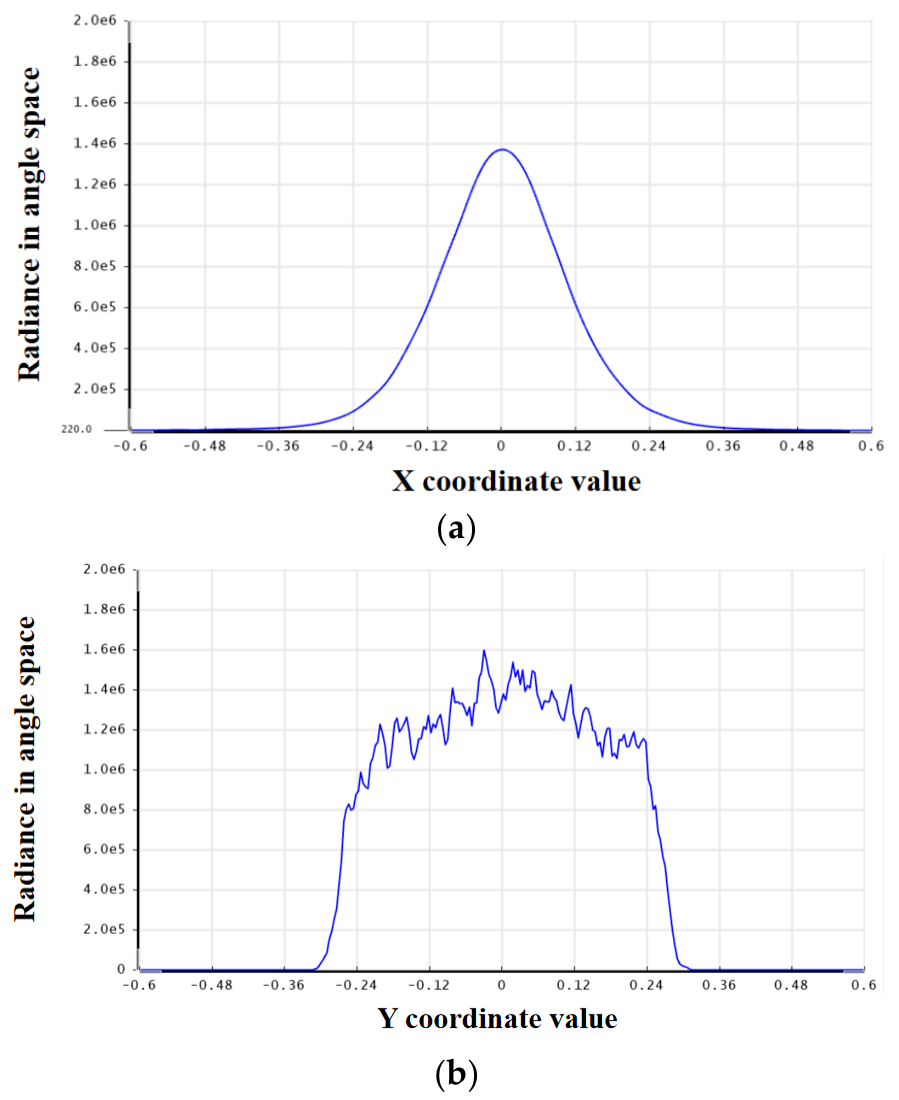
Figure 2. Simulation results of ( a ) the fast axis divergence angle and ( b ) the slow axis divergence angle.